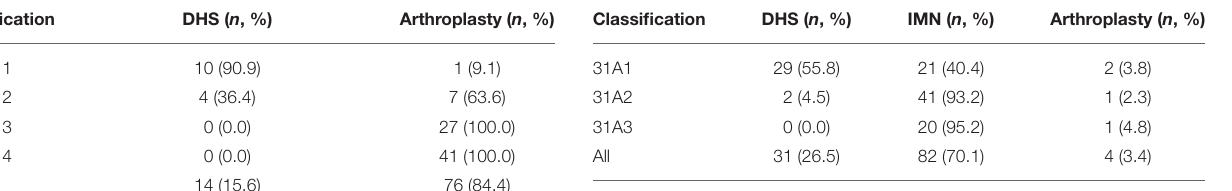
TABLE 4 | Operative procedure for intertrochanteric fracture depending on the AO classification.